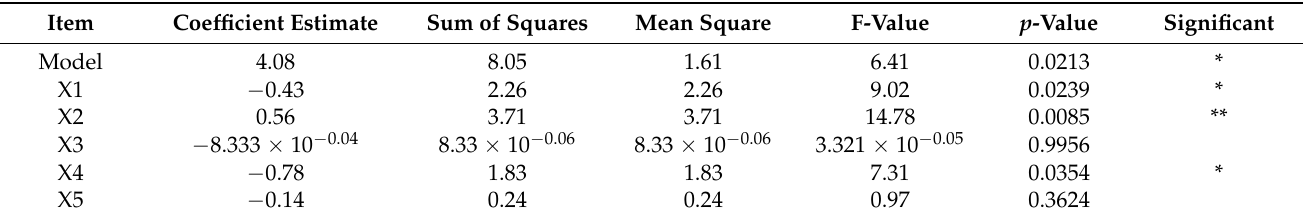
Table 3. Regression coefficients and statistical significance in the fitted regression model based on Plackett–Burman design.